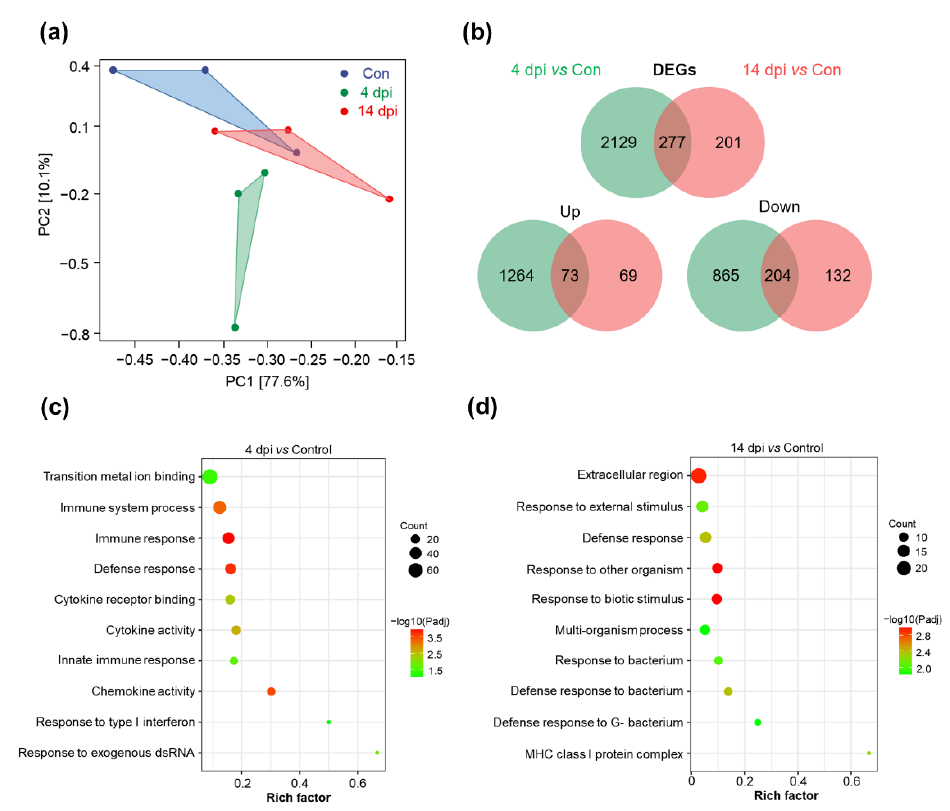
Figure 3. Analysis of the differentially expressed genes (DEGs) in the 4 and 14 dpi groups compared with the control group. ( a ) Principal component analysis (PCA) plot shows clustering of three groups, with axes corresponding to the two different principal components. The blue, green and red dots represent the control, 4 dpi and 14 dpi samples, respectively, with 3 parallel samples in each group. ( b ) Venn diagrams of RNA-Seq showing the overlap of genes upregulated or downregulated in the skin at 4 or 14 dpi versus control fish. ( c , d ) GO enrichment analysis of DEGs related to defense responses and immune responses. The size of the bubbles represents number of genes in a pathway, while the color represents −Log10( p -adj). Rich factor of the X-axis refers to (the number of DEGs annotated to the GO term)/(the total number of genes annotated to the GO term). As a mean of validation of RNA-seq, the RNA samples used for the sequencing database construction were used to detect the expression of 8 DEGs by qPCR (Figure S1f,g). As shown in the bar chart, the qPCR results matched well with the RNA-seq data, which means that the RNA-seq results were reliable. The qPCR primers used for validation are shown in Table